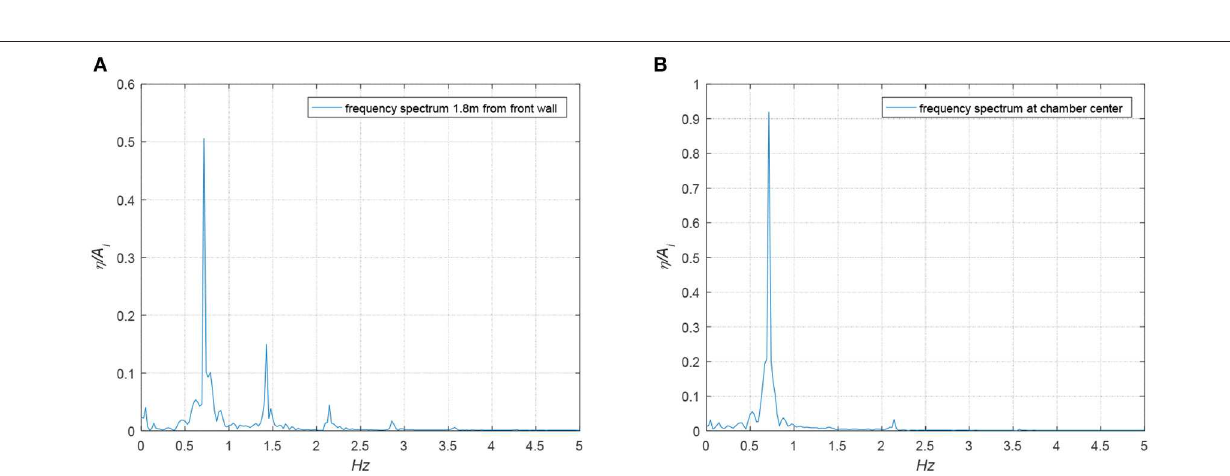
FIGURE 14 | Spectral analysis of surface elevations (A) at a position 1.8m from the front wall of OWC chamber (B) at the chamber center.